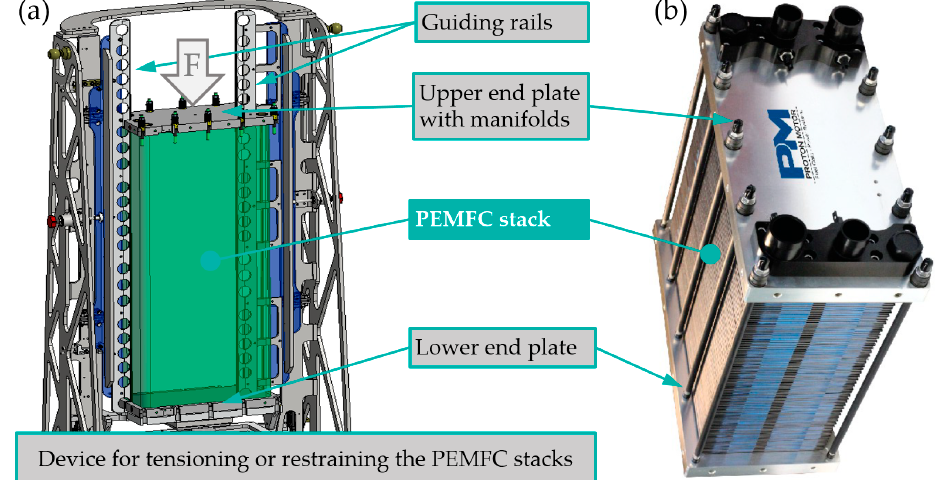
Figure 5. Device for restraining the PEMFC stacks as part of the automated assembly line ( a ) and PEMFC stack of Proton Motor ( b ).